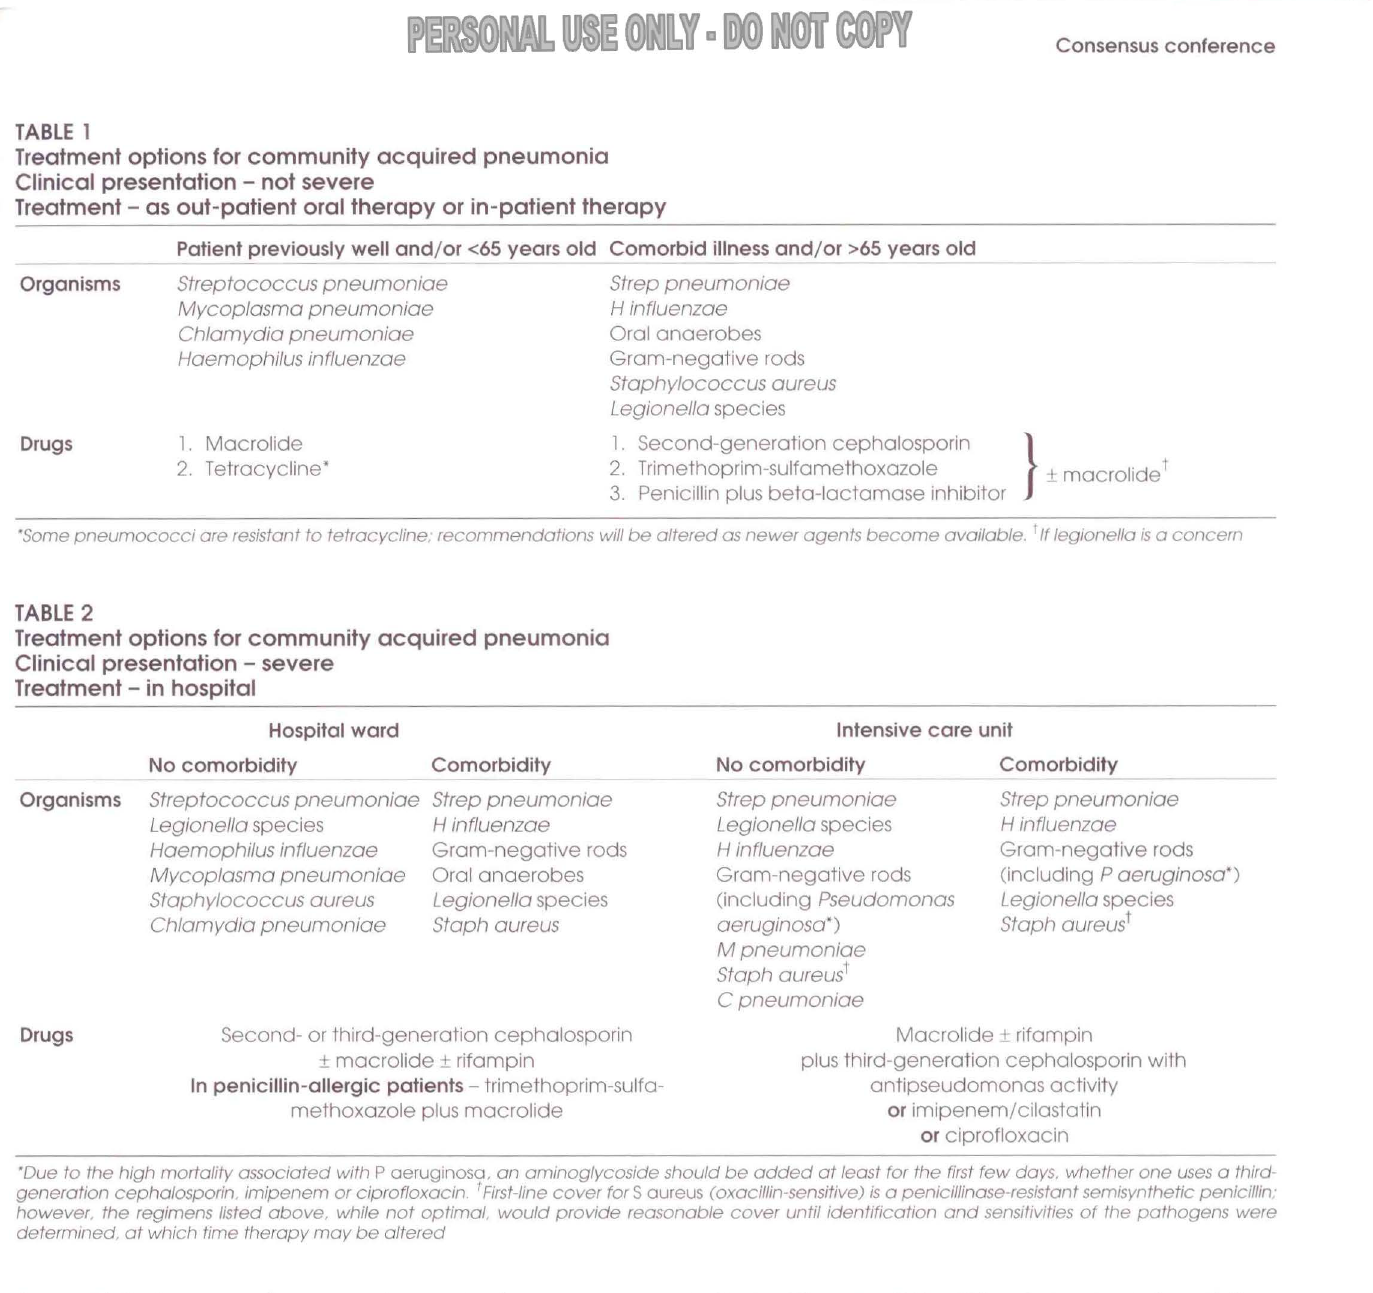
TABLE 1 Treatment options for community acquired pneumonia Clinical presentation - not severe Treatment - as out-patient oral therapy or in-patient therapy Patient previously well and/or <65 years old Comorbid illness and/or >65 years old